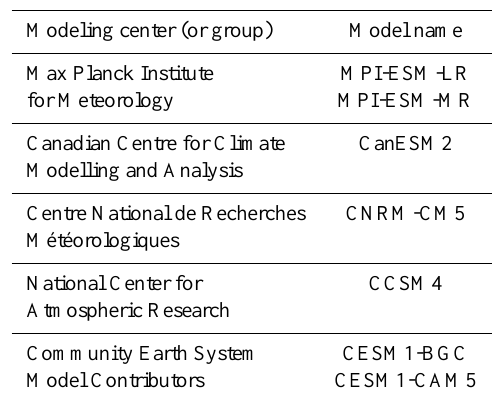
Table 1. List of CMIP5 models analyzed in this